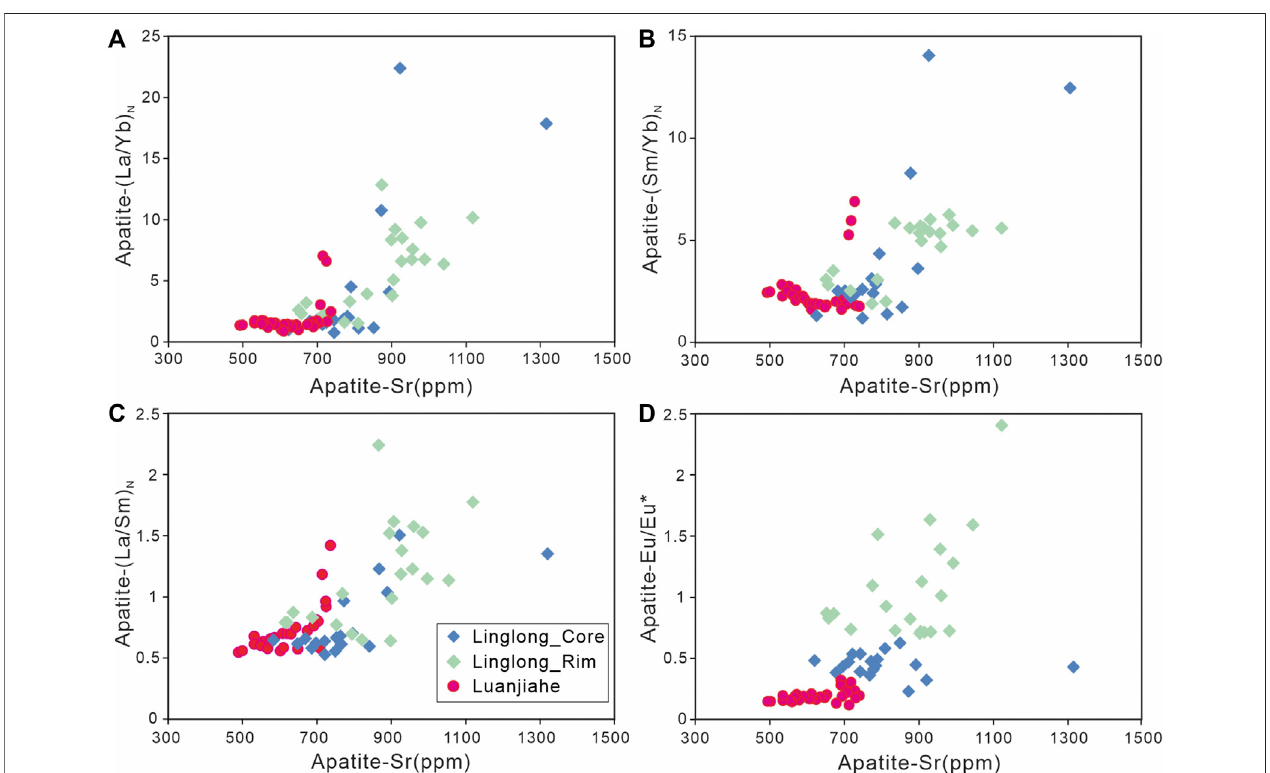
FIGURE 14 | Binary diagrams of Sr and (La/Yb) N (A) , (Sm/Yb) N (B) , (La/Sm) N (C) and Eu/Eu* (D) of apatite from the Linglong and Luanjiahe granites.